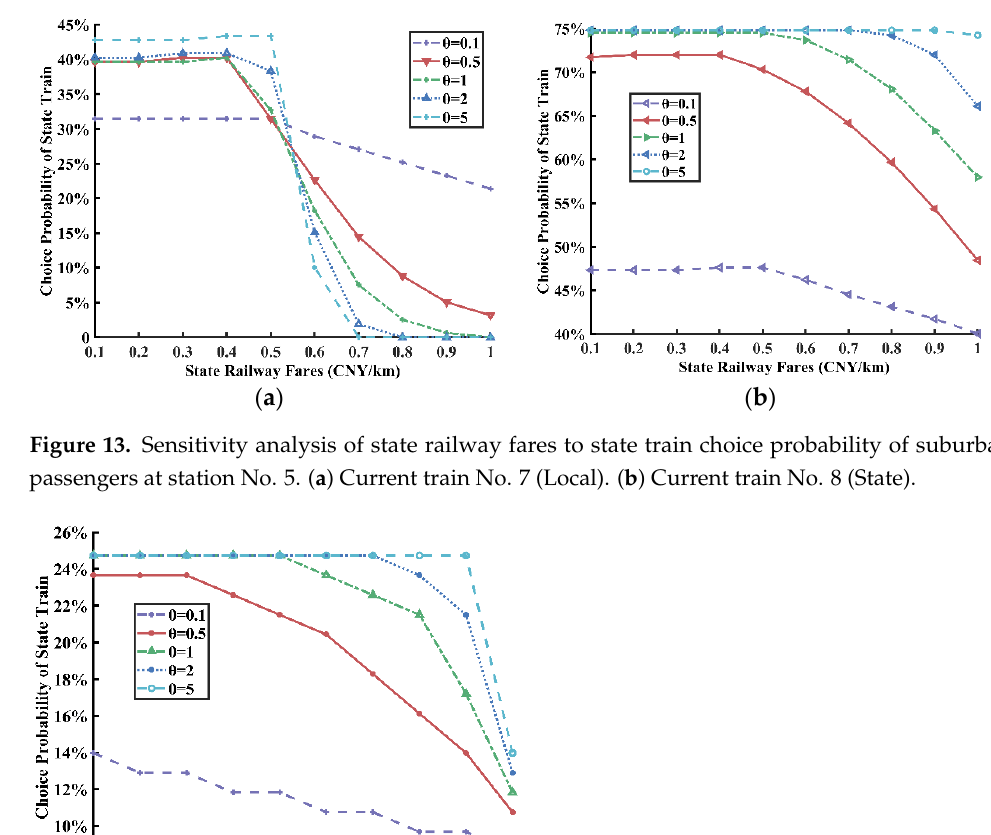
Figure 13. Sensitivity analysis of state railway fares to state train choice probability of suburban passengers at station No. 5. ( a ) Current train No. 7 (Local). ( b ) Current train No. 8 (State).